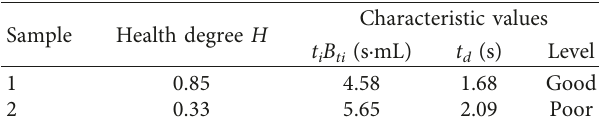
Table 5: Measured health degree, characteristics of fuel con- sumption, and acceleration and deceleration